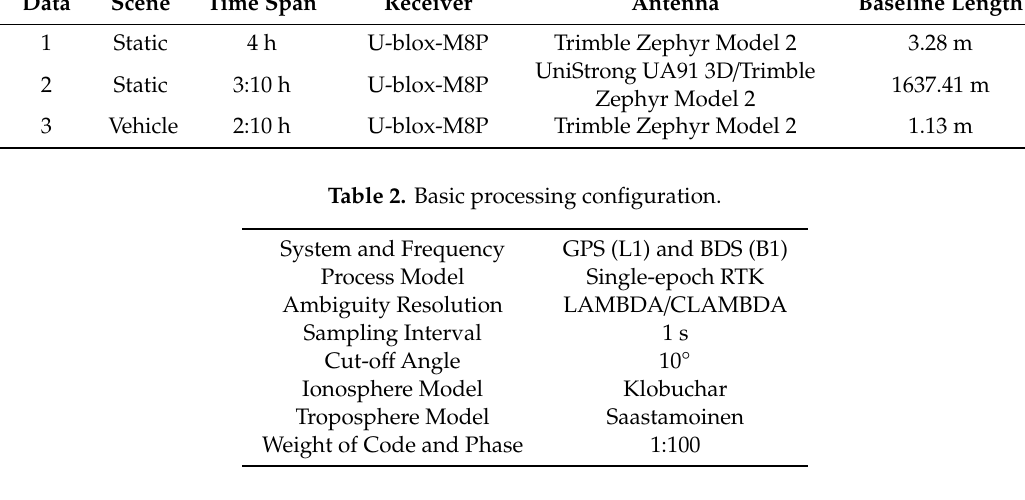
Table 1. Data information.